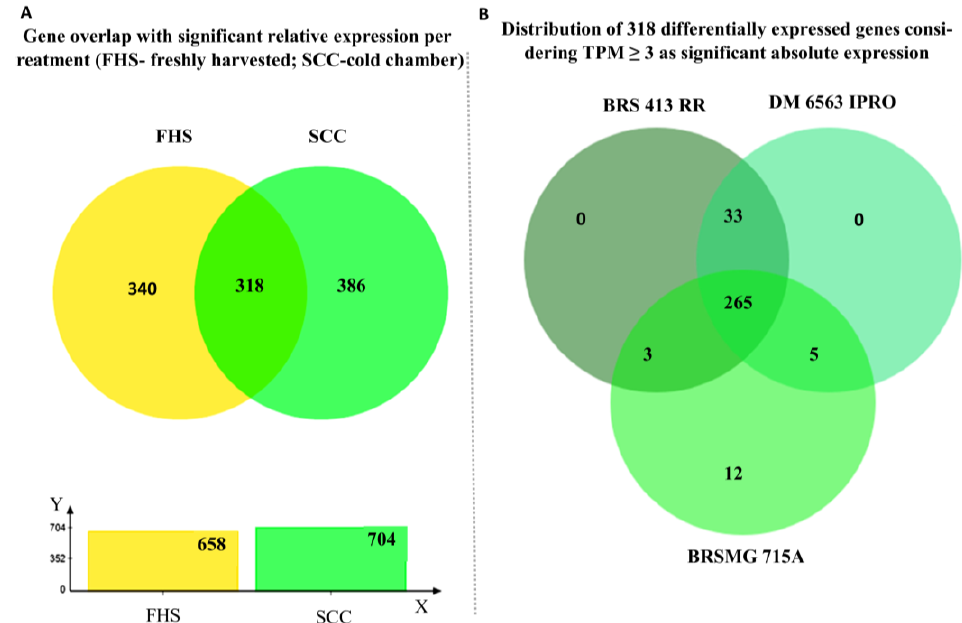
Figure 2. Venn diagrams considering genes with significant relative ( A ) and absolute ( B ) expression in soybean. In A, an overlap of genes with a significant relative expression between the black seed coat cultivar BRSMG 715A and the yellow cultivars BRS 413 RR and DM 6563 iPRO per treatment (FHS—freshly harvested and SCC—cold room). In ( B ), the overlap among cultivar BRSMG 715A and cultivars BRS 413 RR and DM 6563 iPRO for the 318 genes with significant absolute expression (TPM ≥ 3) common to FHS and SCC is shown. Only genes with significant relative expression (log2FC ≤ −1 and ≥ 1) common to FHS and SCC (318) in ( A ) were evaluated for their absolute expression ( B ).